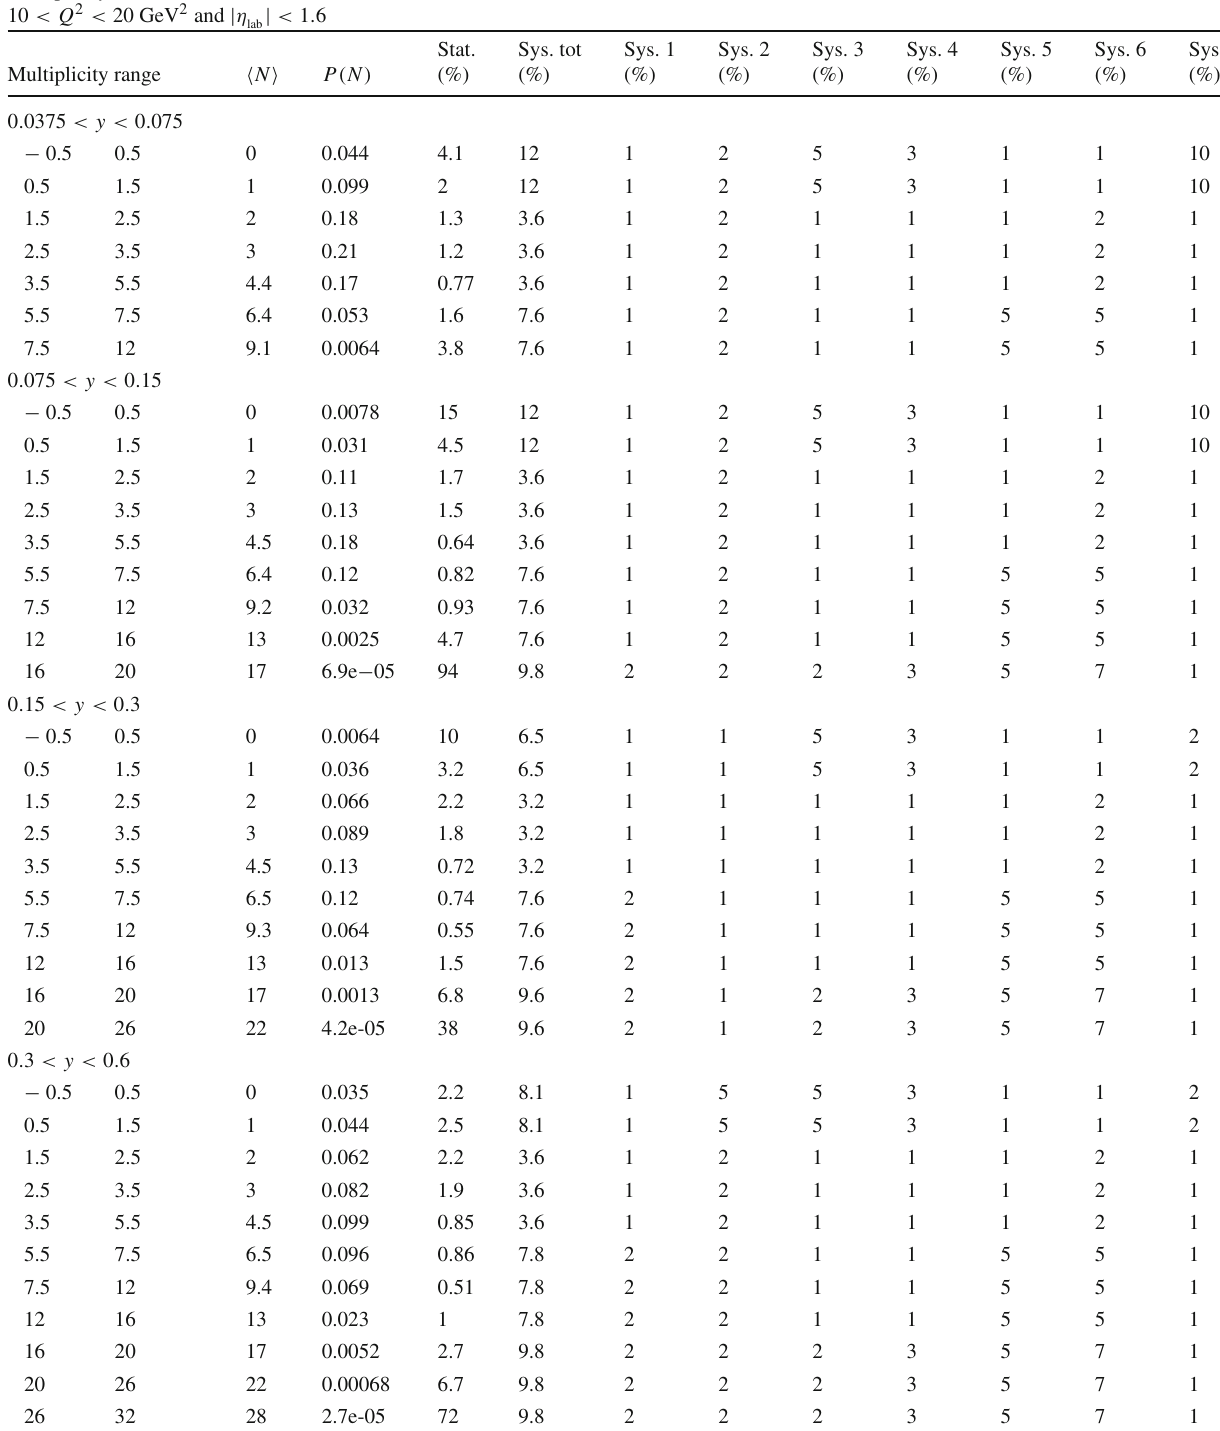
Table 10 Charged particle multiplicity distributions P ( N ) measured √ s = 319GeV with in the ranges of photon virtual- in ep DIS at ity 10 < Q 2 < 20 GeV 2 and charged particle pseudorapidity range Multiplicity distributions in DIS | < 1 . 10 < Q 2 < 20 GeV 2 and | η lab